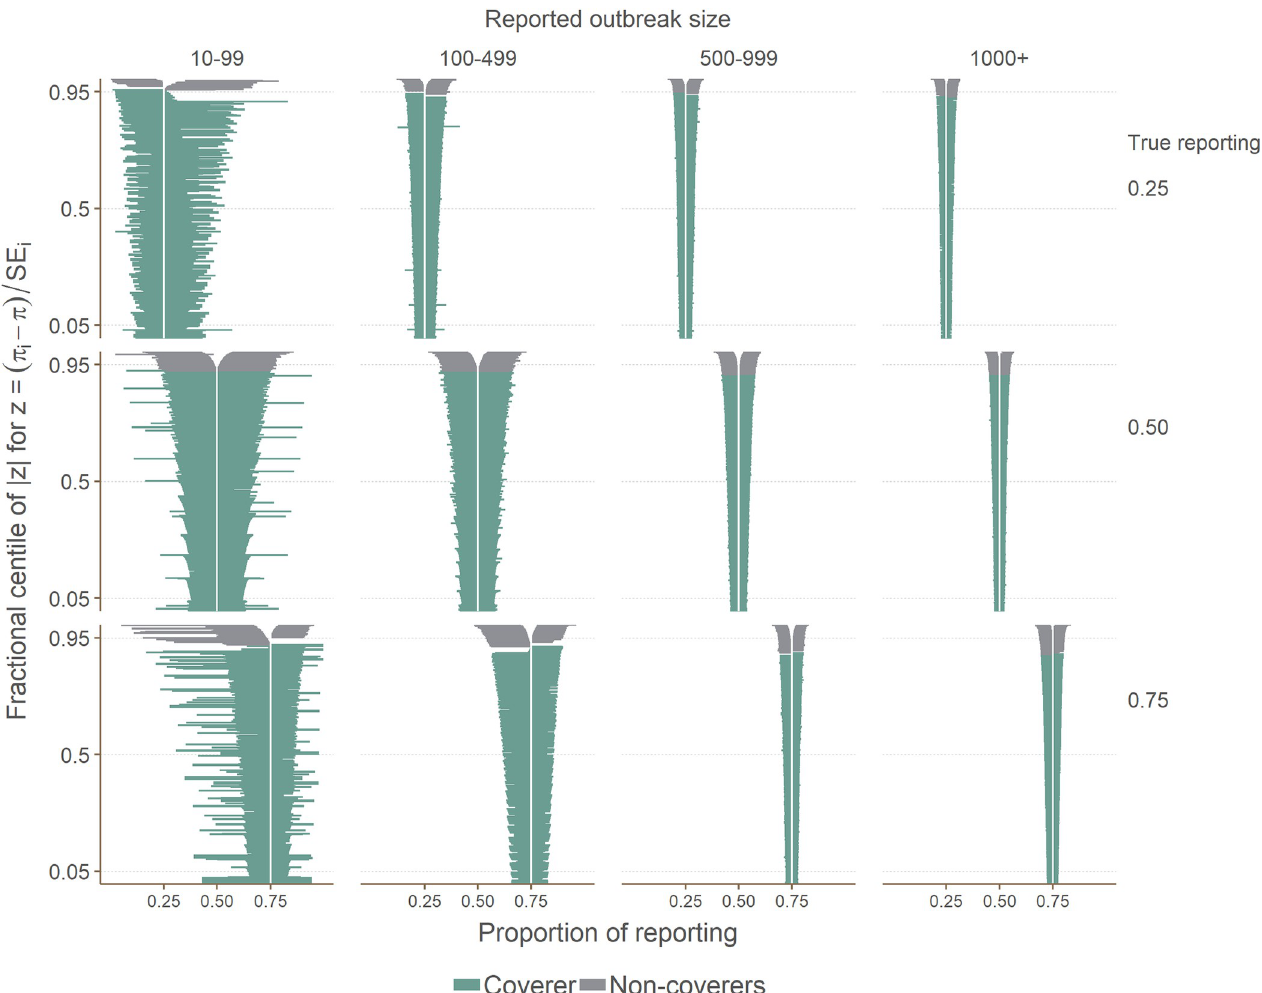
Fig 3. Zip plot of showing coverage results. This graph shows the 95% confidence intervals estimated by the method, broken down by reported outbreak size category and true reporting value. The vertical axis represent the fractional centile of | Z | where Z ¼ ð p i (cid:0) p Þ ranked by their level of coverage and thus the vertical axis can be used to determine the proportion of confidence intervals that contain the true value where 0.95 would represent a coverage of